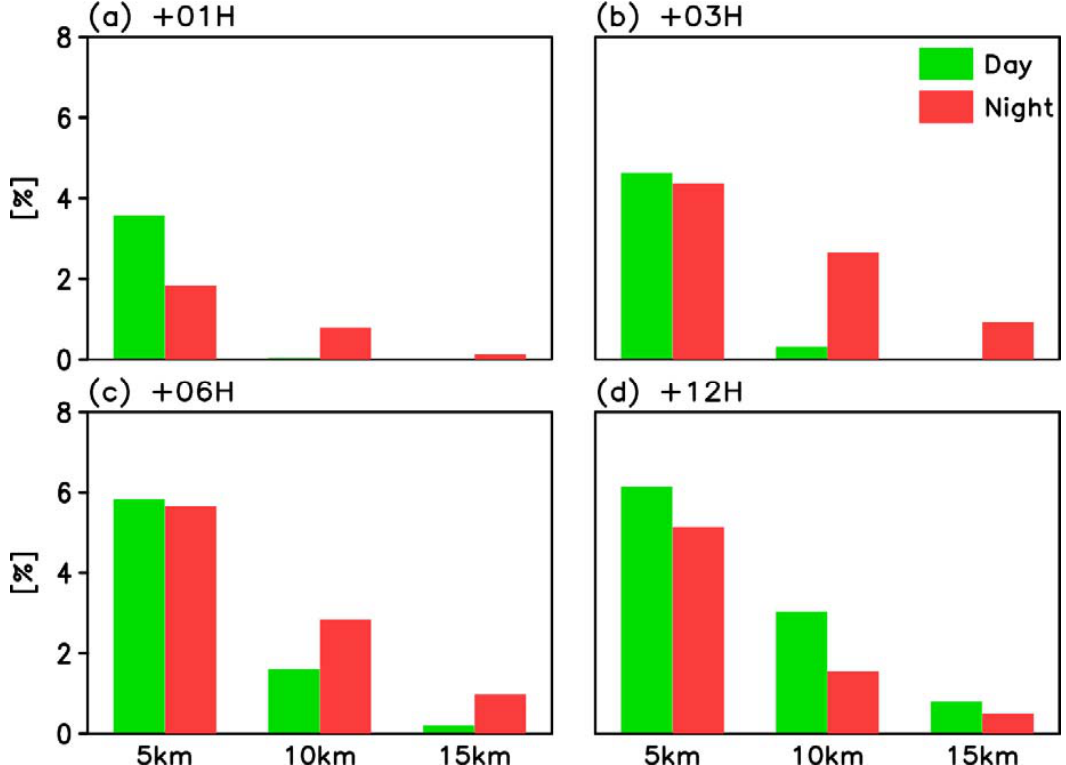
Figure 9. The accumulated hit rate of the concentration higher than 30 μ g m − 3 . The values indicate the areal averages within the 5, 10, and 15 km radius from the emission source in ( a ) 1 h, ( b ) 3 h, ( c ) 6 h, and ( d ) 12 h after the emission starts, respectively. Only the values over the land are averaged to assess the vulnerability of the local